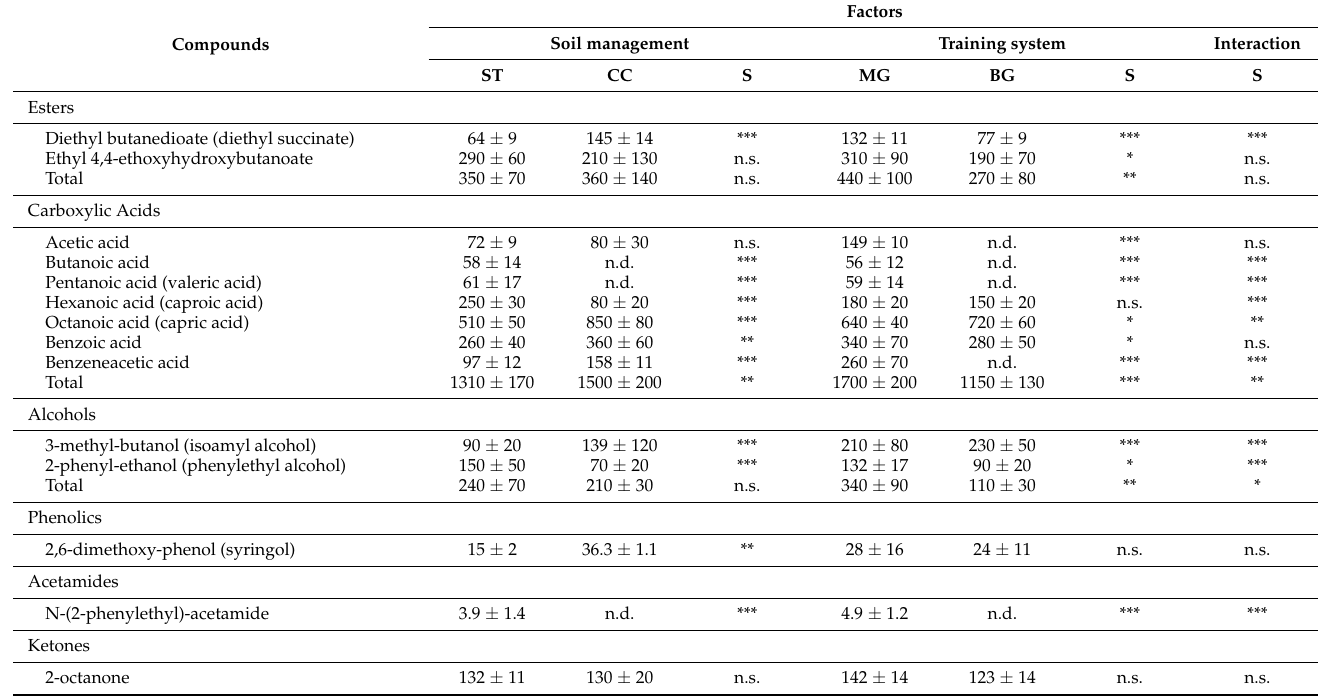
Table 5. Concentration ( µ g/L—means values and standard deviation) of single glycosylate volatile compounds identified in the Negroamaro vines from the two soil managements and training systems by